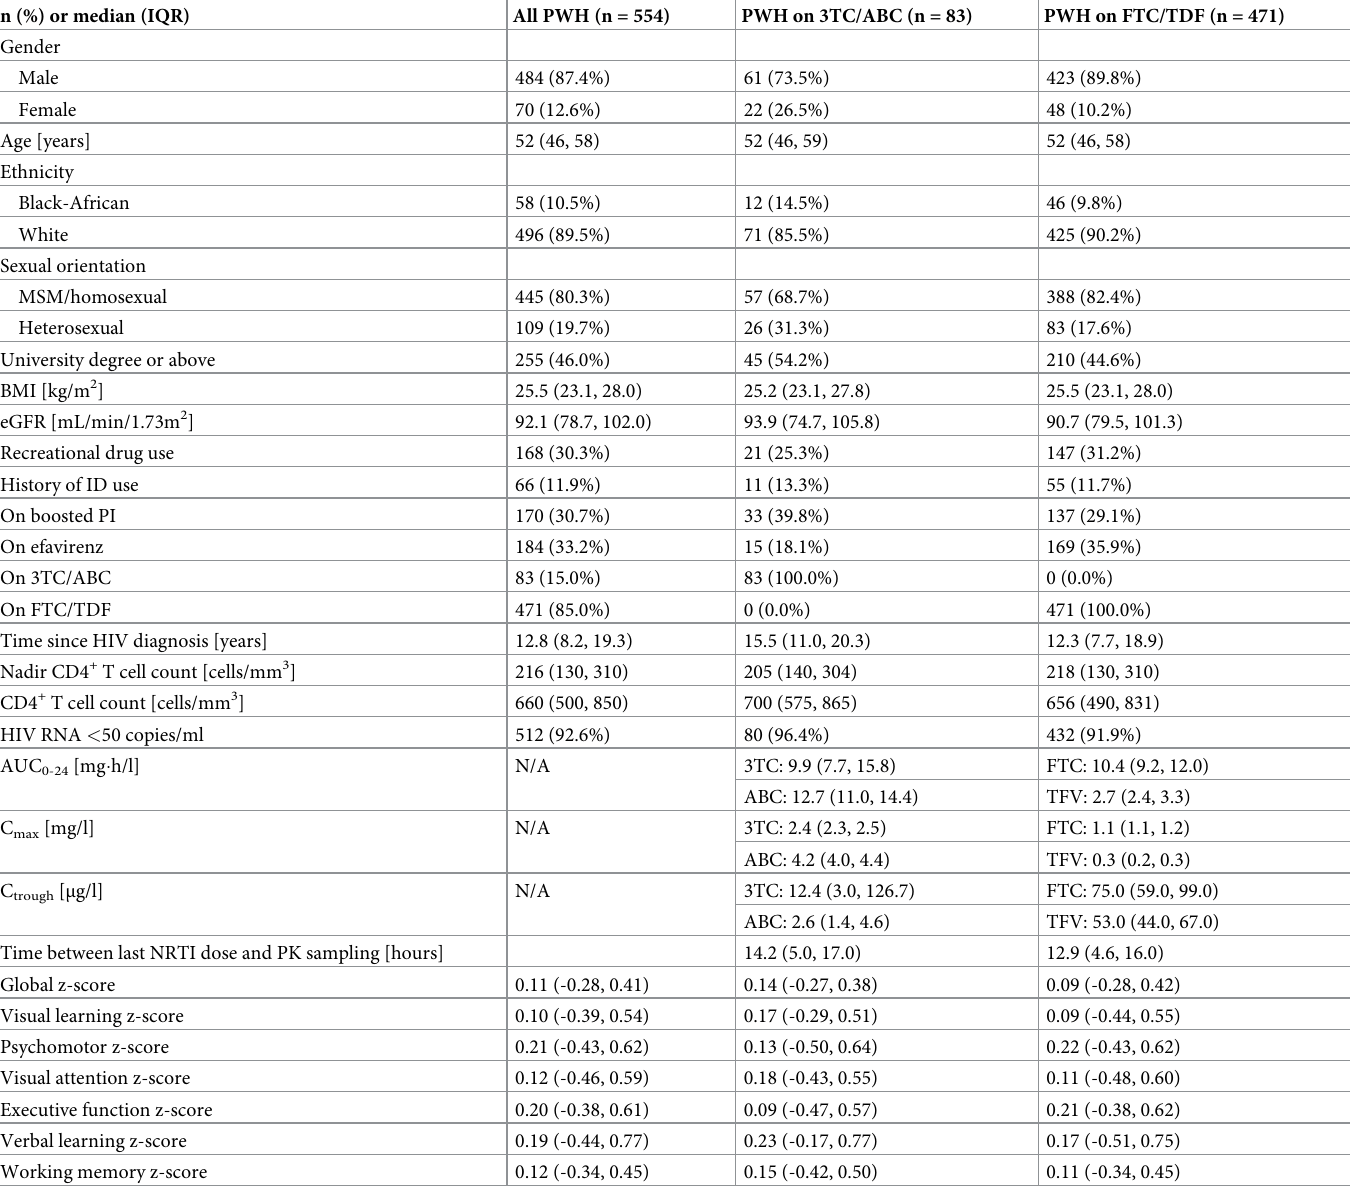
Table 1. Characteristics of POPPY participants with PK and cognitive